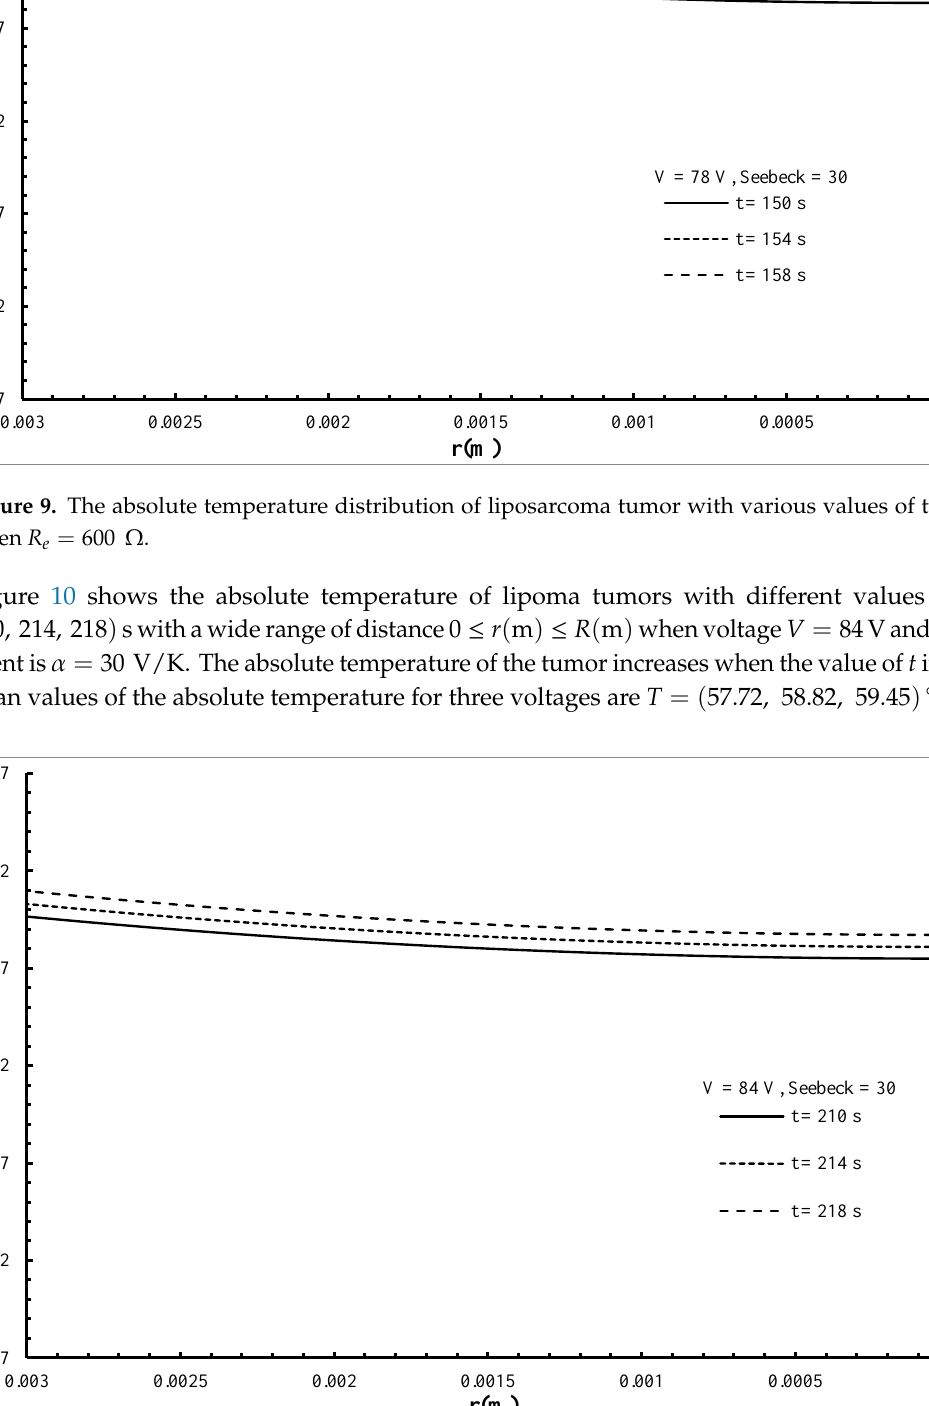
Figure 10 . The absolute temperature distribution of lipoma tumor with various values of time when 1300 R   . e